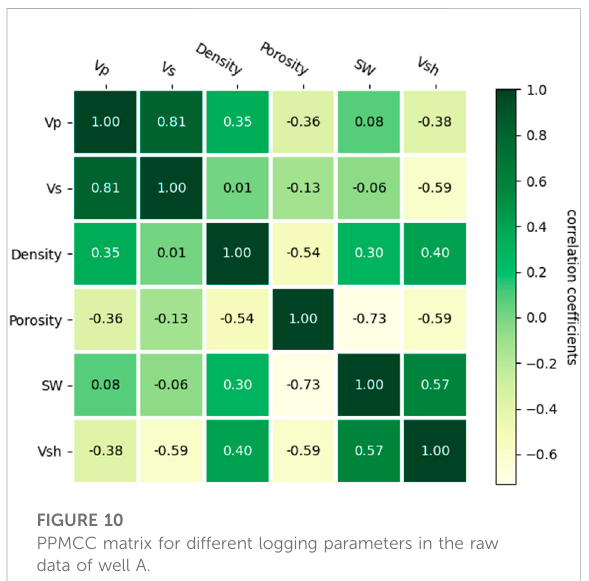
FIGURE 10 PPMCC matrix for different logging parameters in the raw data of well